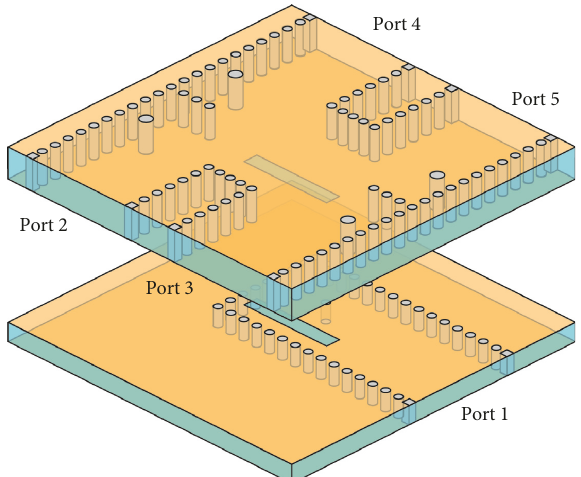
Figure 9: 3D exploded view of the feeding network of the 2 × 2